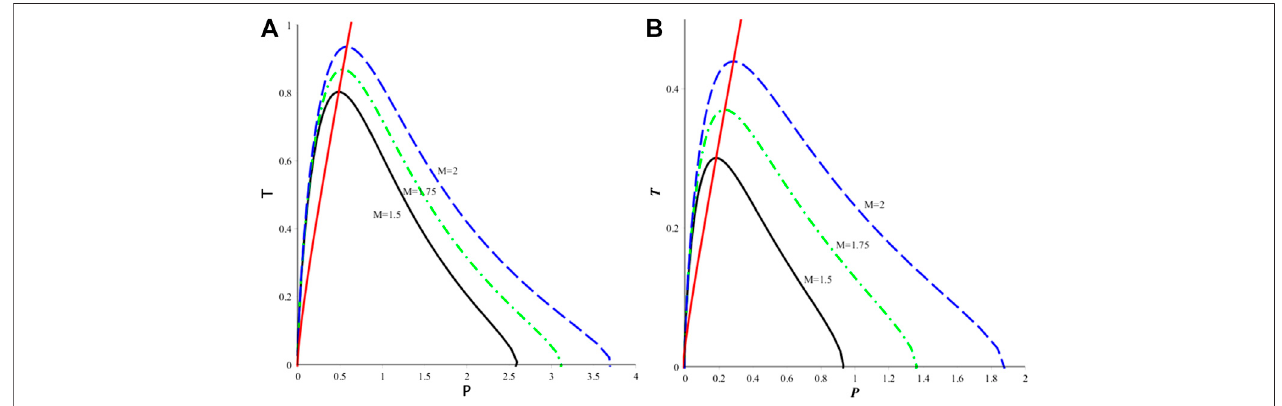
FIGURE 8 | Isenthalpic curves and inversion curve with (cid:5) μ 2 (cid:1) 0 . 1, (cid:5) μ 3 (cid:1) 0 . 2, (cid:5) μ 4 (cid:1) 0 . 001, k (cid:1) 1, e (cid:1) q (cid:1) 5 and n (cid:1) 4 (A) Yang-Mills quasitopological, (B) Maxwell